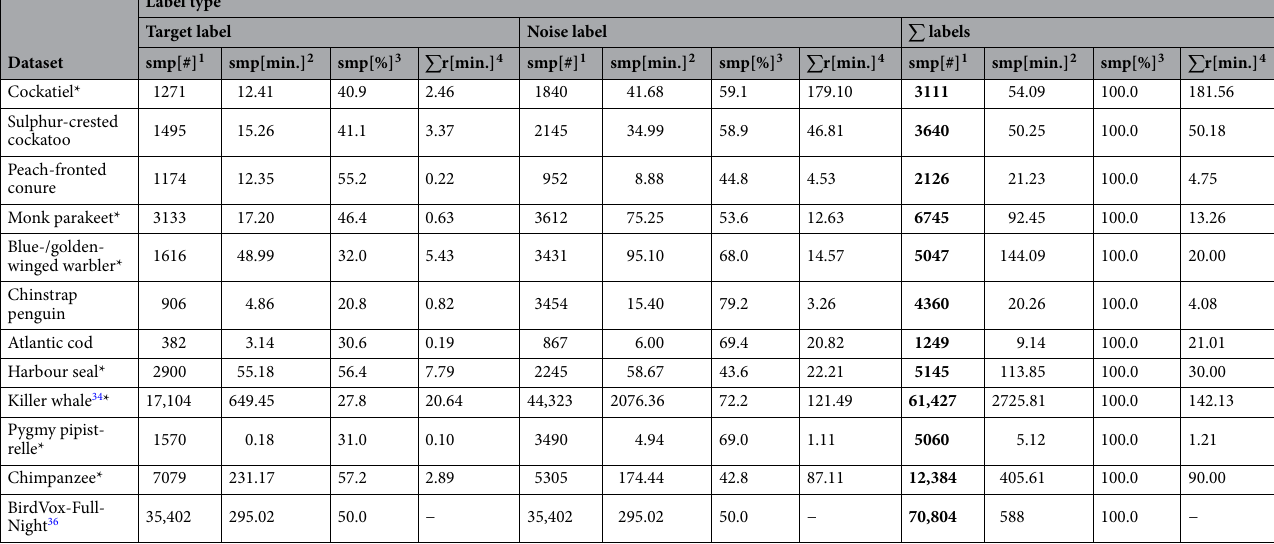
Table 1. Animal-specific data corpora and distribution. *Additional noise augmentation training samples: [1.1] cockatiel—180 (2.87 min.), [1.2] monk parakeet—105 (1.08 min.), [1.3] Blue-/Golden-winged